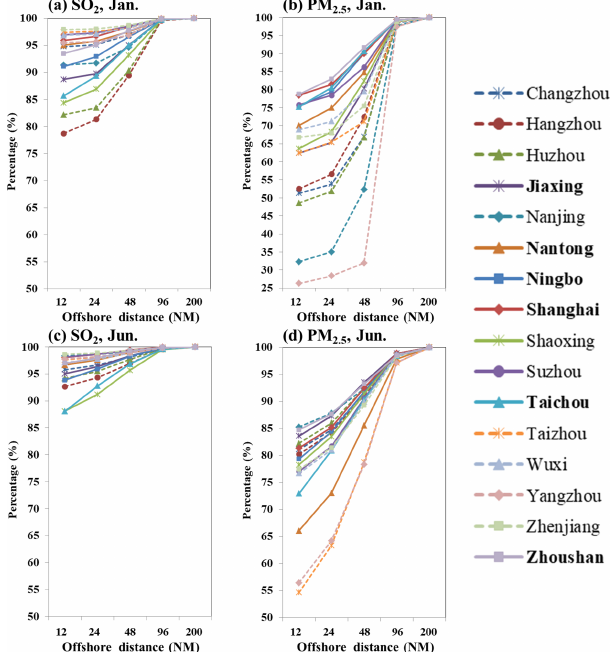
Figure 5. Cumulative contributions of shipping emissions in the YRD at distances within 12NM of shore (including inland-waters), 24NM from shore, 48NM from shore, 96NM from shore, and 200NM from shore to PM 2 . 5 concentrations (a, c) and SO 2 con- centrations (b, d) in January 2015 (a, b) and in June 2015 (c, d) . The names of coastal cities are in bold in the